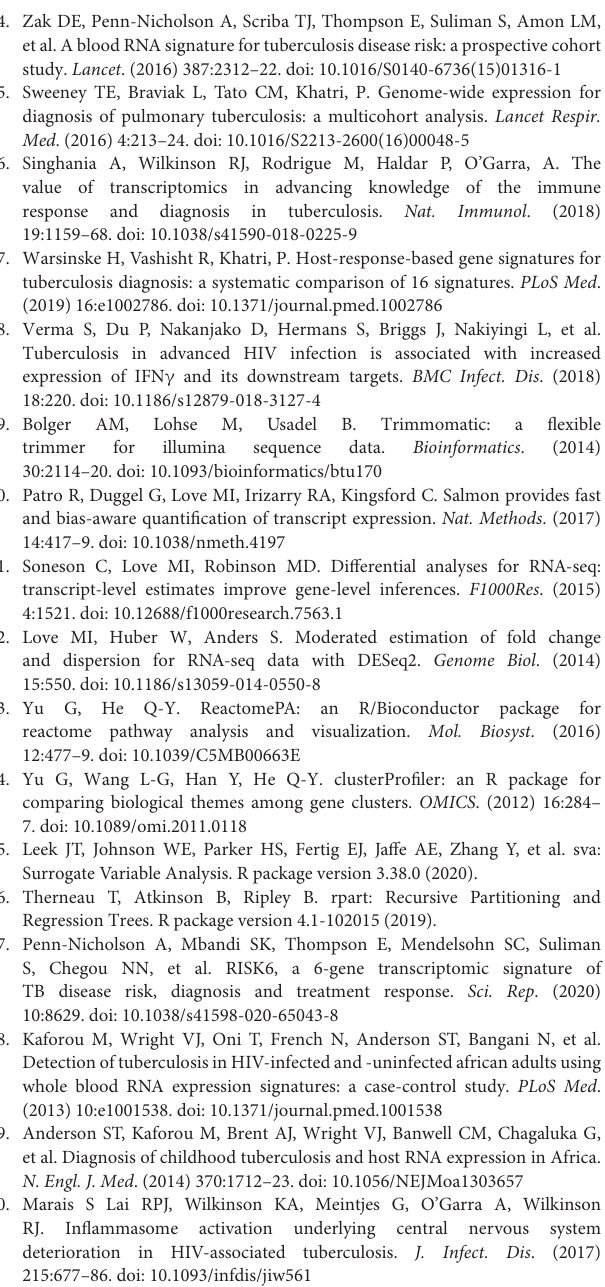
Supplementary Figure S2 | Heatmap of the differentially expressed genes (DEG) for TB identified in the India (A) and Uganda (B) cohorts. Supplementary Figure S3 | The dot plot demonstrates the presence of Decision-tree genes (INSL3 and RAB20) in previously proposed TB gene expression signatures (A) . Boxplots show the associations of CD3 (B) , CD8 (B) , and CD4 (C) cell counts and HIV viral load (D) with TB-HIV co-infection status in the India cohort. Clinical variables were compared among cases (TB-HIV) and controls (HIV-only) using the Wilcoxon test. Only CD3 and CD8 cell counts were significantly associated with TB status.